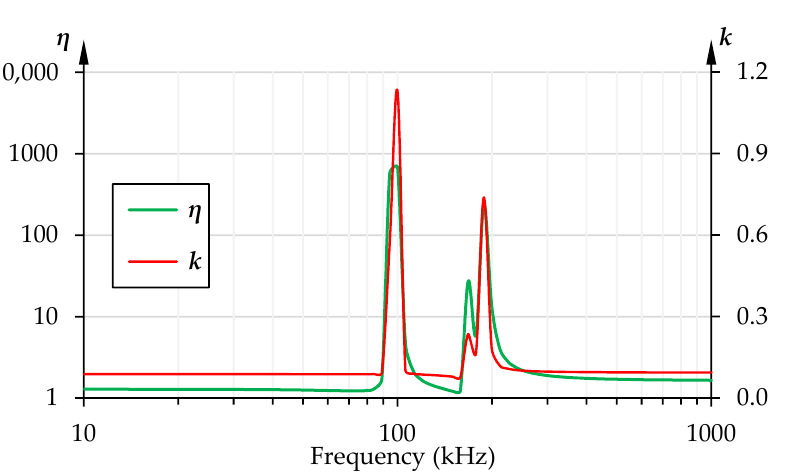
Figure 14. Frequency response of the magnetic meta-hose with the highest magnetic field ratio k ( ν = 0.45, µ m = 26) identified at f r = 100 kHz.